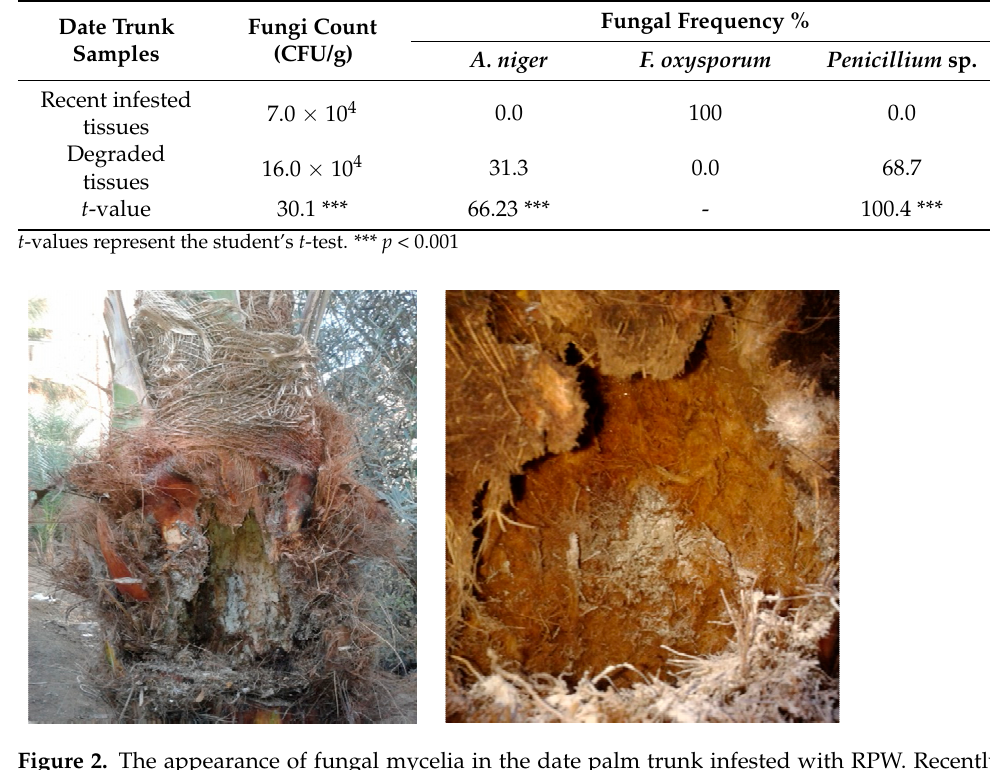
Table 3. Pathogenicity test of F. oxysporum isolates on date palm germinated seeds.